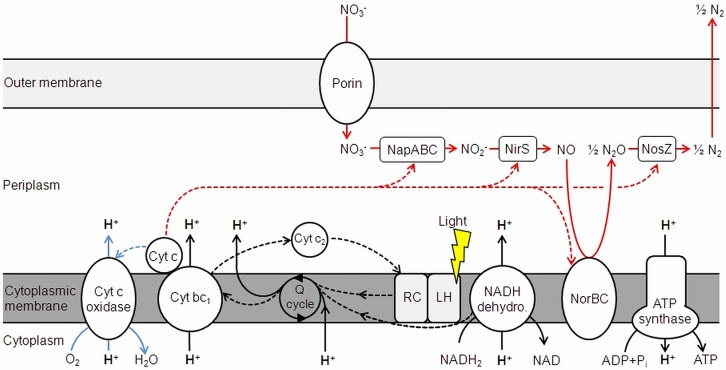
Electron transduction (dashed lines) and proton translocation in D. shibae. Denitrification is shown in red, aerobic respiration in blue. NapABC, nitrate reductase; NirS, nitrite reductase; NorBC, nitric oxide reductase; NosZ, nitrous oxide reductase; Cyt, cytochrome; Q cycle, quinone cycle. Modified and extended after Wagner-Döbler et al. (2010) and Laass et al. (2014).